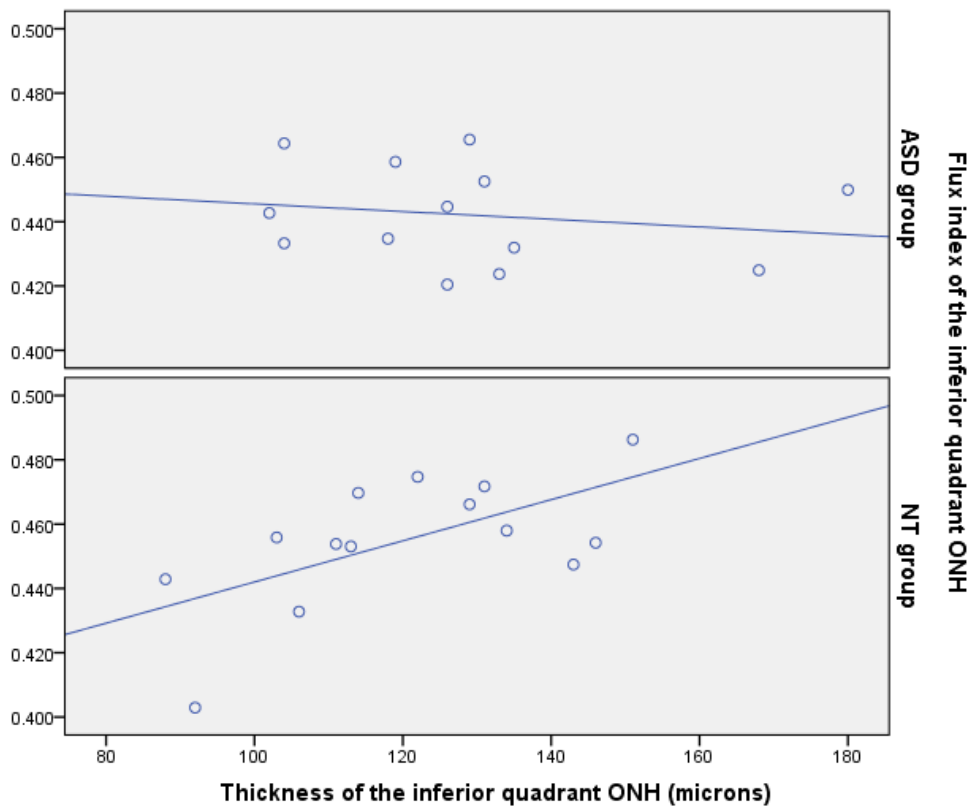
Figure 14. Scatterplots representing the association between peripapillary retinal nerve fiber layer (RNFL) thickness and flux index at the inferior peripapillary quadrant in autism spectrum disorder (ASD) group and neurotypical group (NT). Each point represents the left eye value of each patient. ONH = optic nerve head. Best correlation lines have been added.